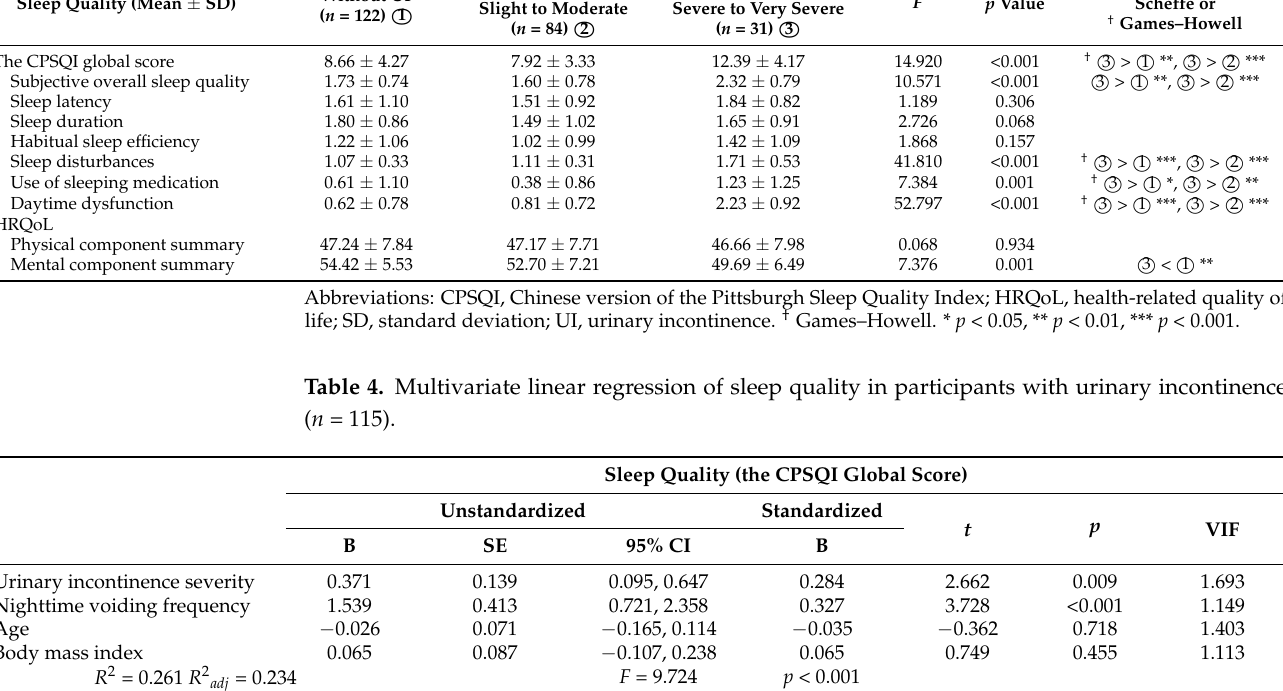
Sleep Quality (Mean ± SD)